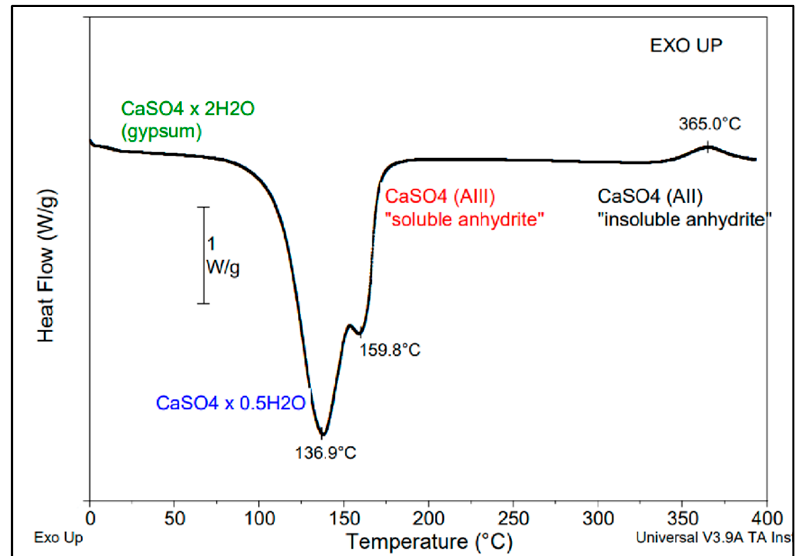
Figure 4. Thermal transformations of CS dihydrate as revealed by DSC heating to 400 °C (DSC method, 10 °C/min).